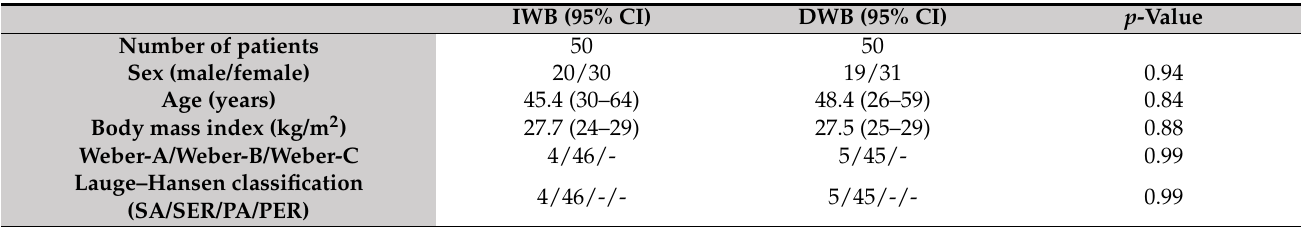
Table 1. Characteristics of the study